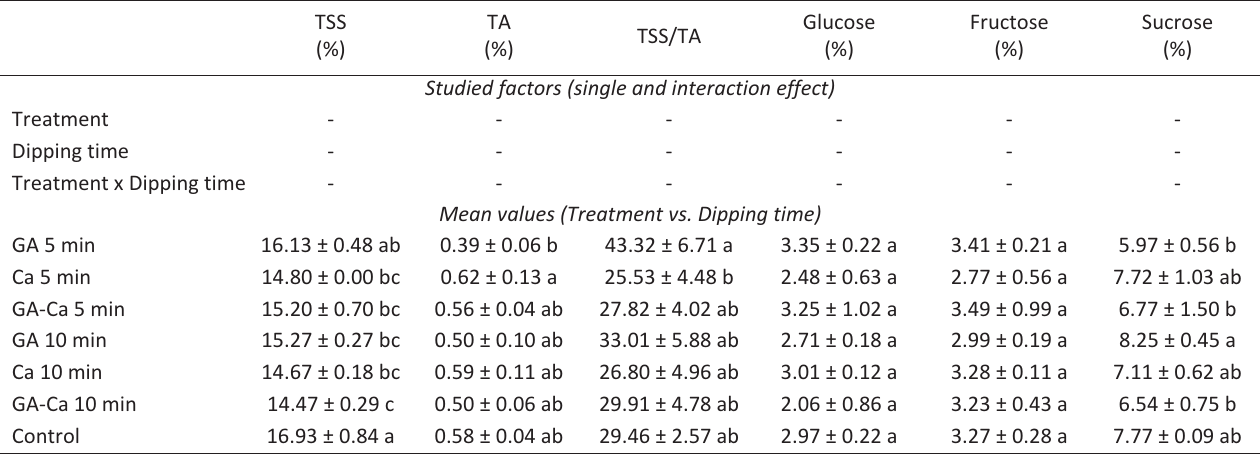
* Results marked with (+) indicate that the P­value (p < 0.05) for the single or interaction can be considered to draw conclusions; mea­ nwhile, results marked with (­) indicate that the P­value (p > 0.05) for the single or interaction are not significant to draw conclusion in the text. Mean values ± SE in each column followed by the same lower­case letters are not statistically different by Duncan’s multiple range test (p < 0.05). Treatments: GA, Ca, mix GA­Ca, Control ­ no use of GA and Ca. Dipping time: 5 and 10